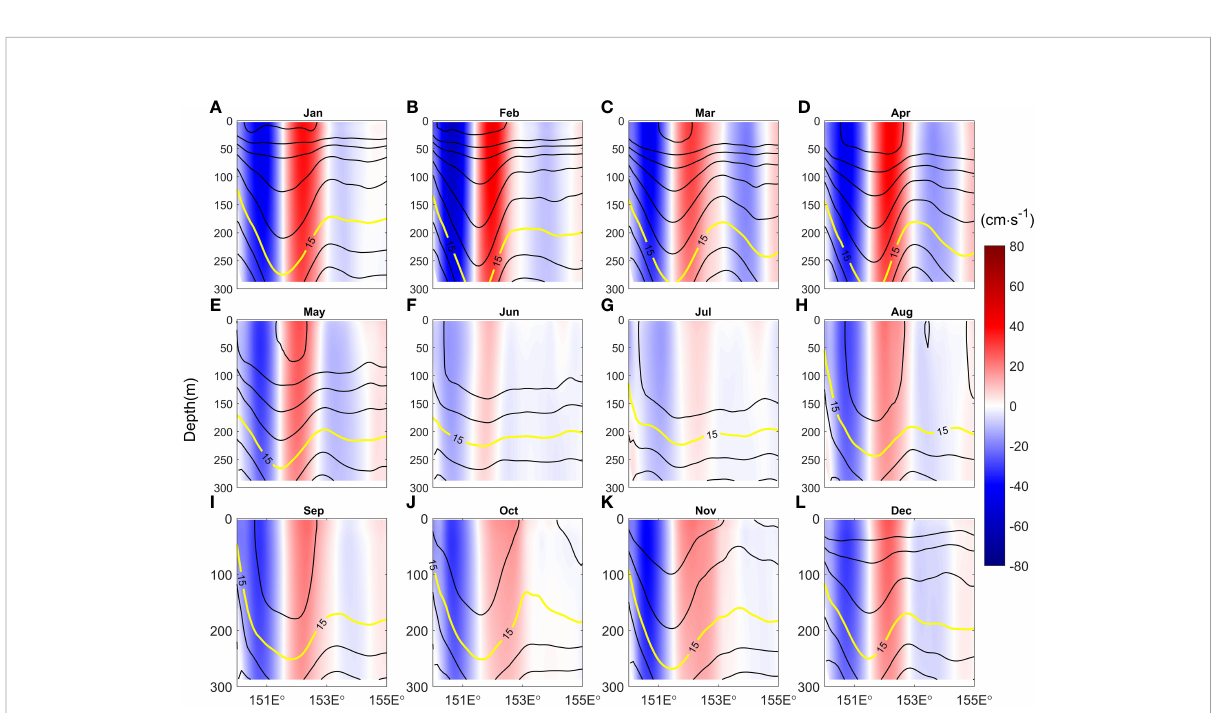
FIGURE 13 Zonal distributions of temperature (contour with 1 interval, units: °C) and velocity (shaded color, units: cm s -1 ) in the upper 300 m along 38°S from OFES during July 1999-October 2009 for (A) January, (B) February, (C) March, (D) April, (E) May, (E) June, (G) July, (H) August, (I) September, (J) October, (K) November and (L) December.